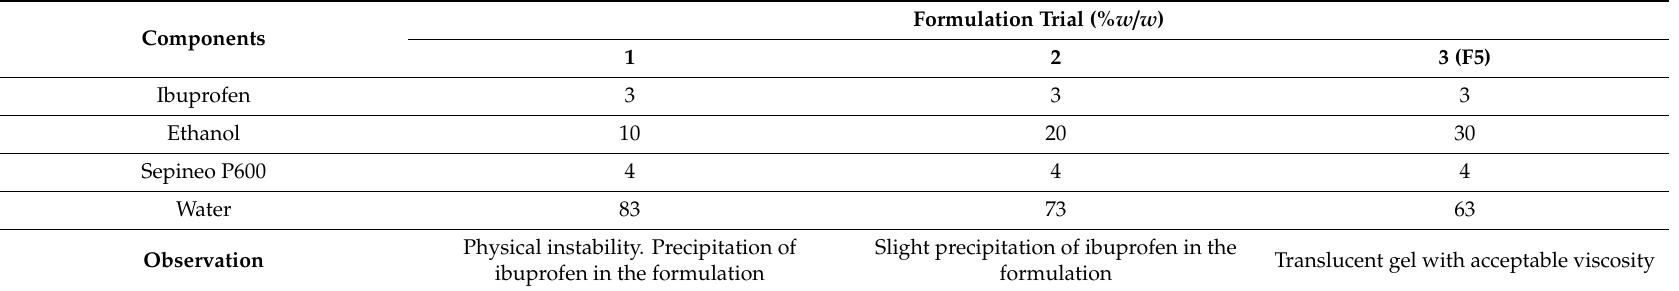
Table A2. Optimization of emulgel formulation.